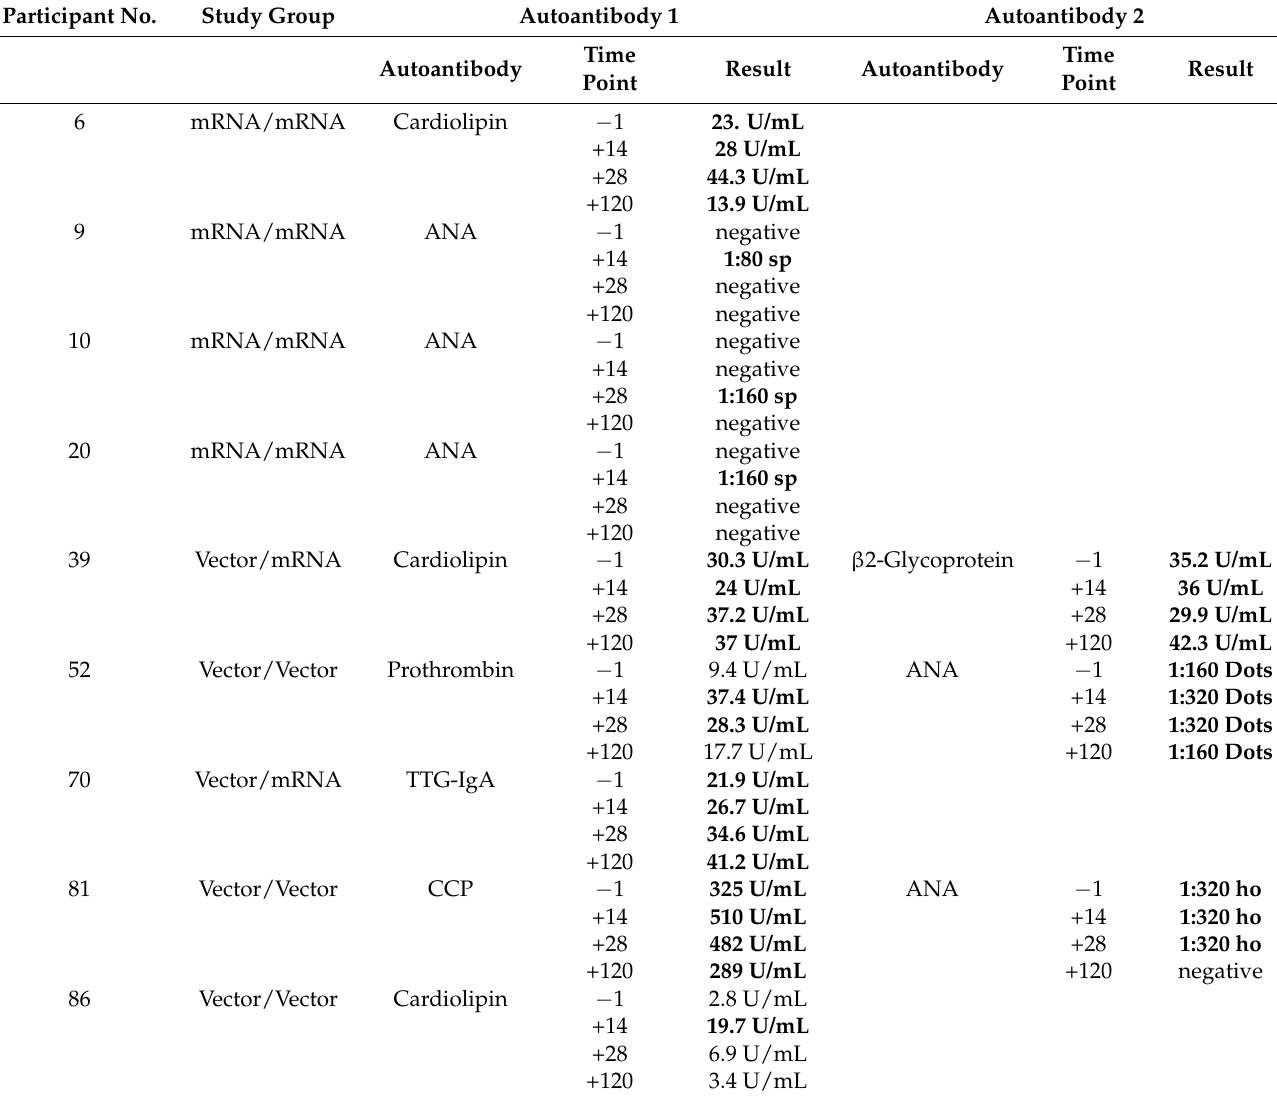
Table 2. Summary of participants with increasing values for selected autoantibodies. Bold values are above the respective cutoff. Sp—speckled; Dots—nuclear dots; cen—centromere;